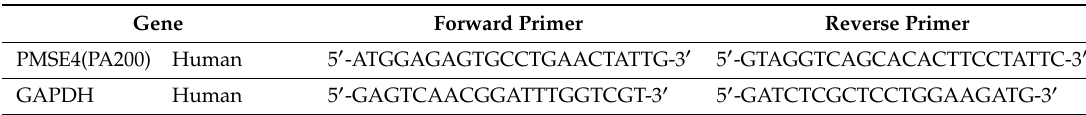
Table 3. Primers used in RT-qPCR